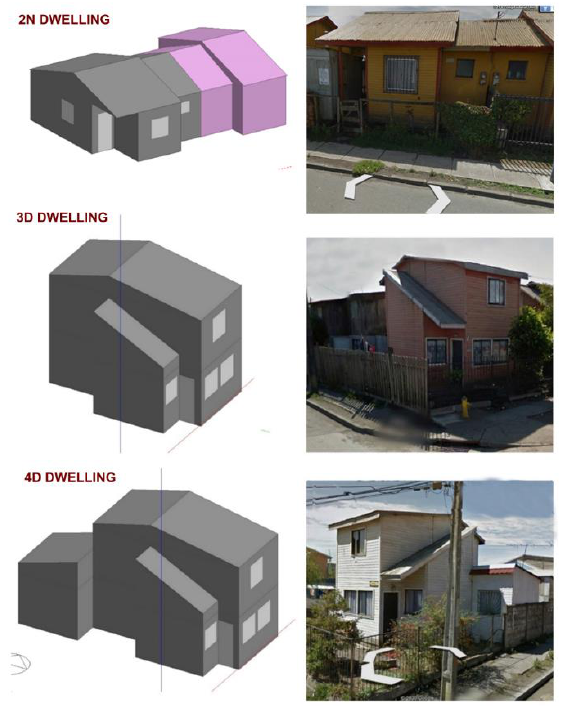
Figure A6. Geometry and pictures of the 2N, 3D, and 4D dwellings (authors’ own preparation).